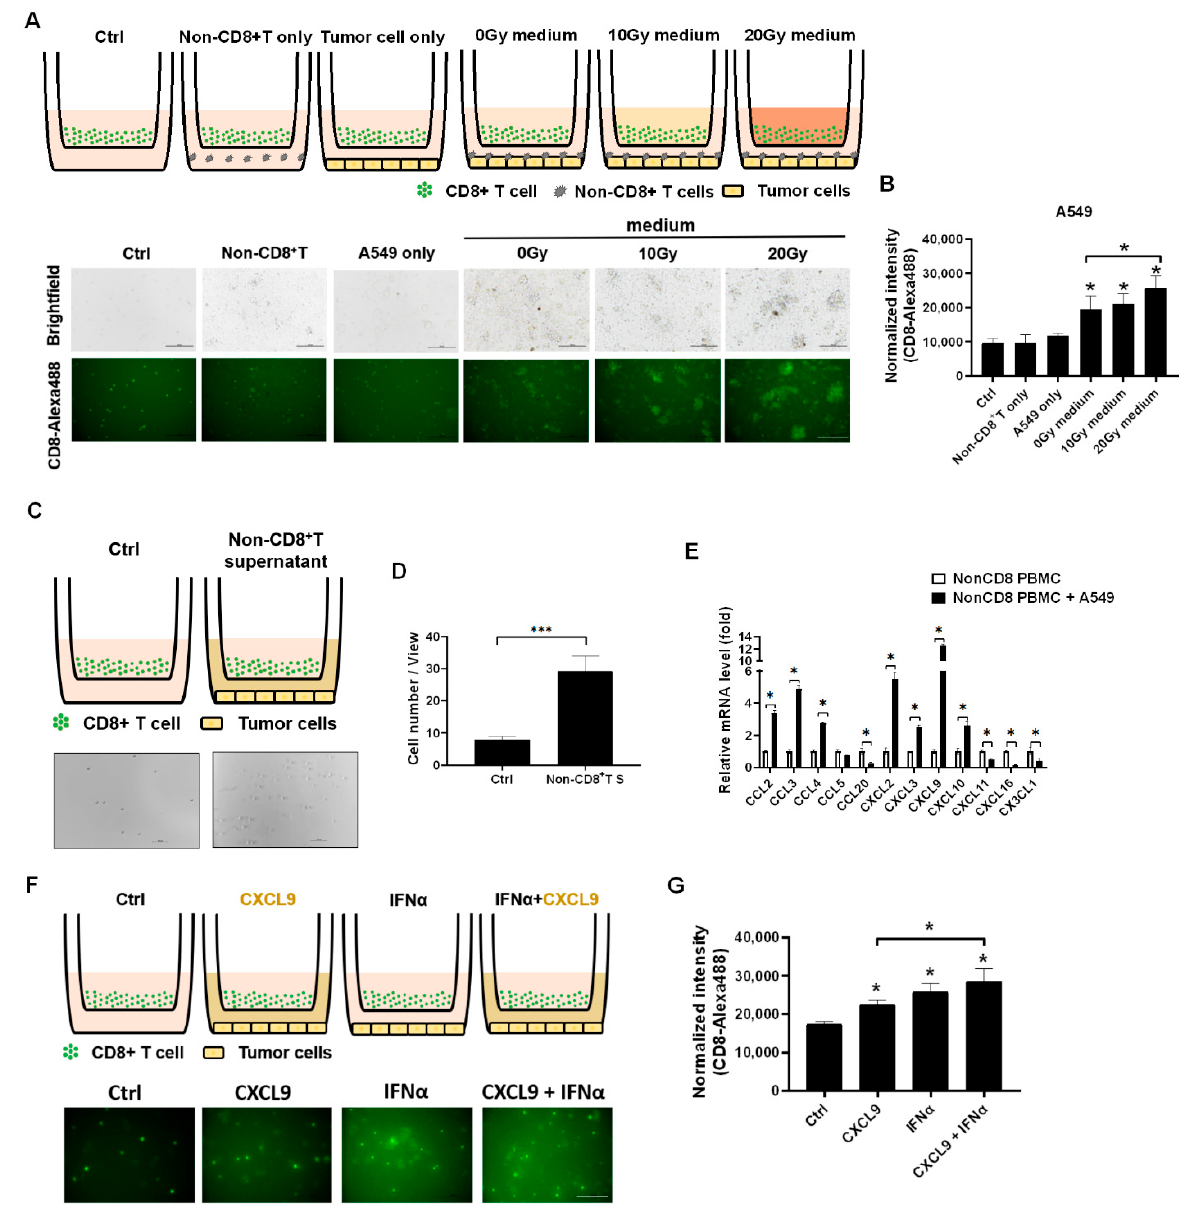
Figure 2. Irradiation-treated A549 medium and nonCD8 + PBMCs supernatant increased CD8 + T cell migration in vitro. ( A ) The isolated CD8 + T cells treated with the irradiation-treated A549 medium loaded on top of a 0.3 μ m plate and lung cancer A549 or PC9 cells with nonCD8 + PBMCs loaded on down well for 24-h incubation. The CD8 + T cells were pre-labeled with Alexa488-labeled anti-CD8 antibody. ( B ) Quantitation of Alexa488 fluorescence representing CD8 + T cell migration activity was measured and compared based on 3-times repeat. ( C ) Since the A549 with nonCD8+ PBMCs enhanced CD8 + T cell migration, the supernatant of A549 with nonCD8 + PBMCs post 24 h was collected and investigated whether which increased CD8 + T cell migration. ( D ) CD8 + T cells migrating through 0.3 μ m transwell were calculated and compared based on 3-times repeat. ( E ) The chemokines associated with CD8 + T cell trafficking were detected in nonCD8 + PBMCs after incubation with A549 for 24 h, including CCL2 , CCL3 , CCL4 , CCL5 , CCL20 , CXCL2 , CXCL3 , CXCL9 , CXCL10 , CXCL11 , CXCL16 , and CX3CL1 . ( F ) The healthy CD8 + T cells were treated with individual 20 ng/mL of CXCL9 or IFN α for 24 h and ( G ) the Alexa488 fluorescence was captured and measured based on 3-times repeat. The quantification was calculated based on 3-times repeat in qPCR assay. Scale bar, 100 μ m. * p < 0.05, *** p < 0.001.